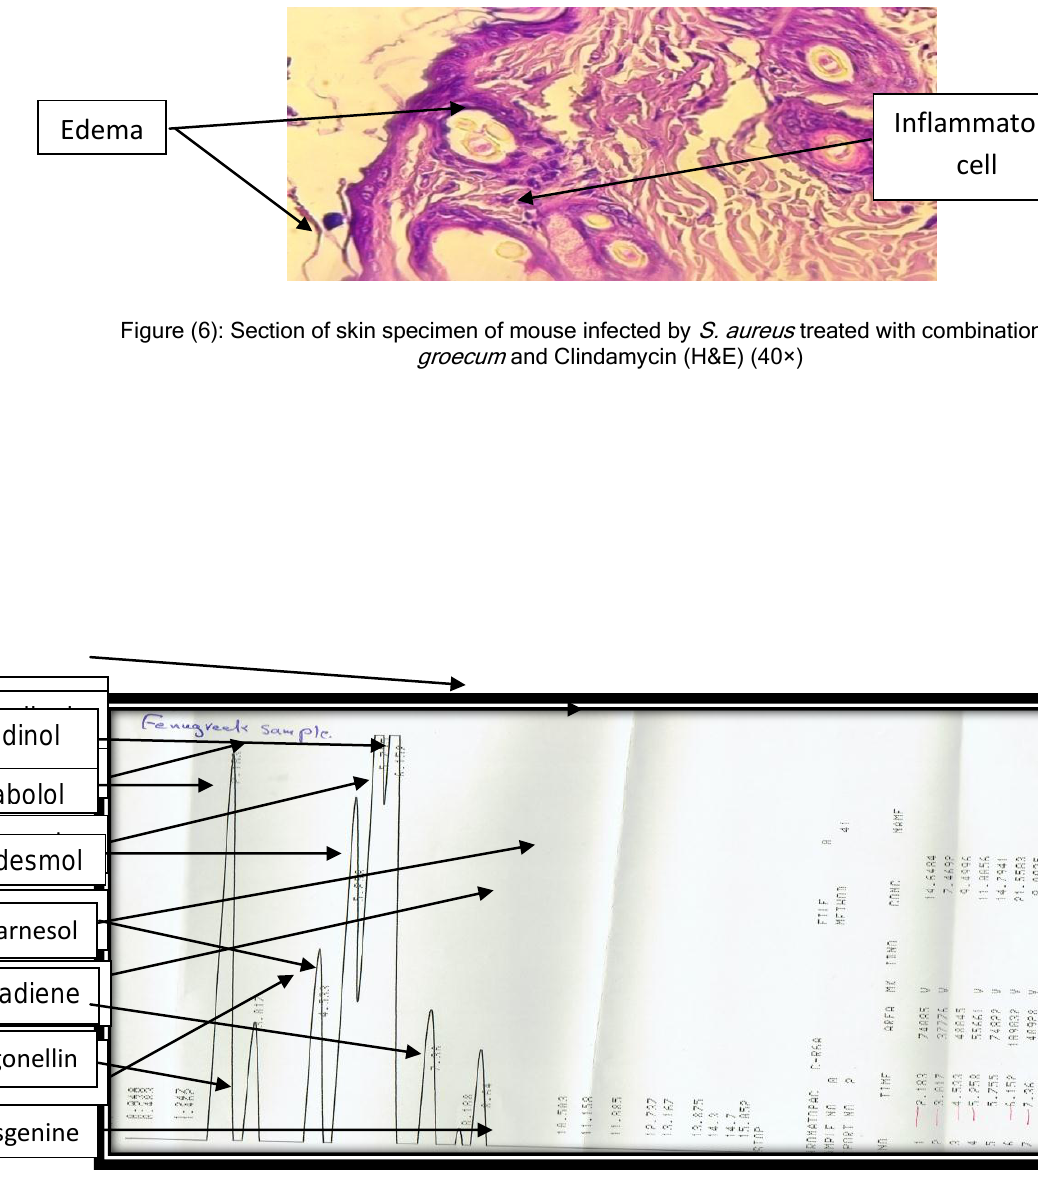
Figure (7): HPLC chromatography of fenugreek standard and sample, B1: fenugreek standard, B2: fenugreek